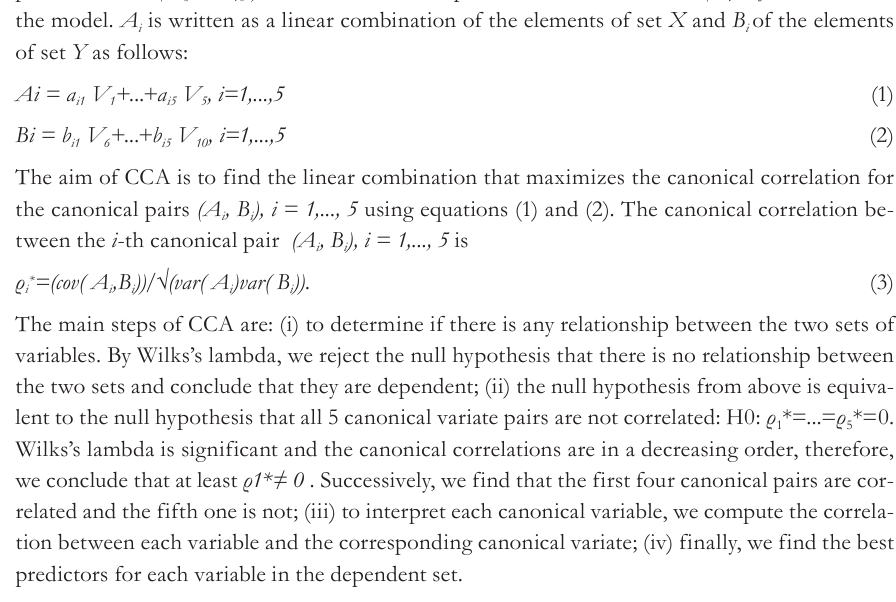
Fig. 1– Canonical correlation framework. Source: own